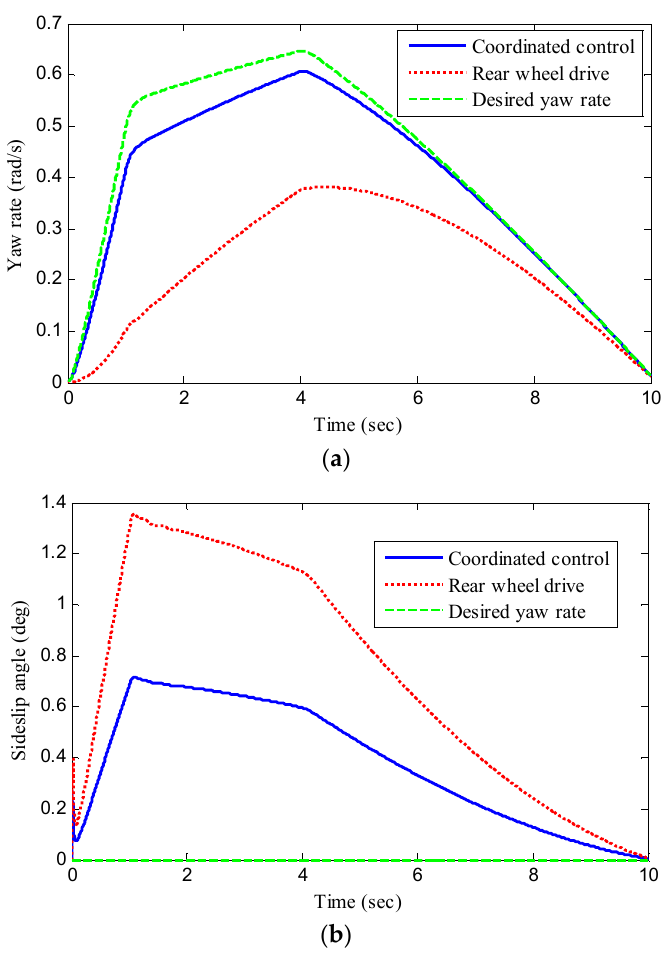
Figure 17. Total motor load power in case study 2.